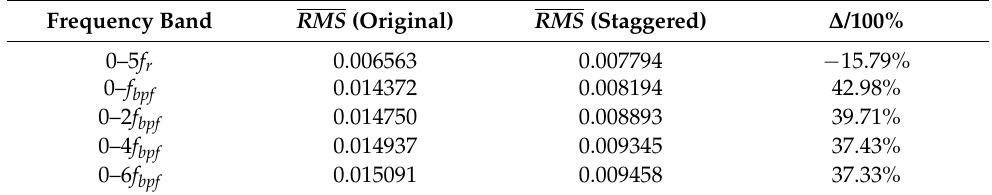
Table 5. RMS average values and variation values in frequency band under design condition. Frequency